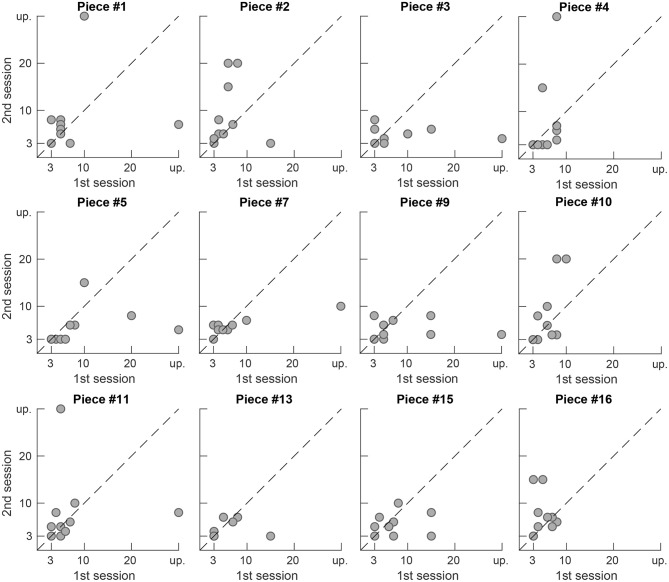
Preferred number of retained components in the second session plotted vs. the preferred number in the first session per piece. Points close to the dashed diagonal line indicate equal ratings in the first and second presentation of a piece. Unprocessed signals are denoted by “up”.